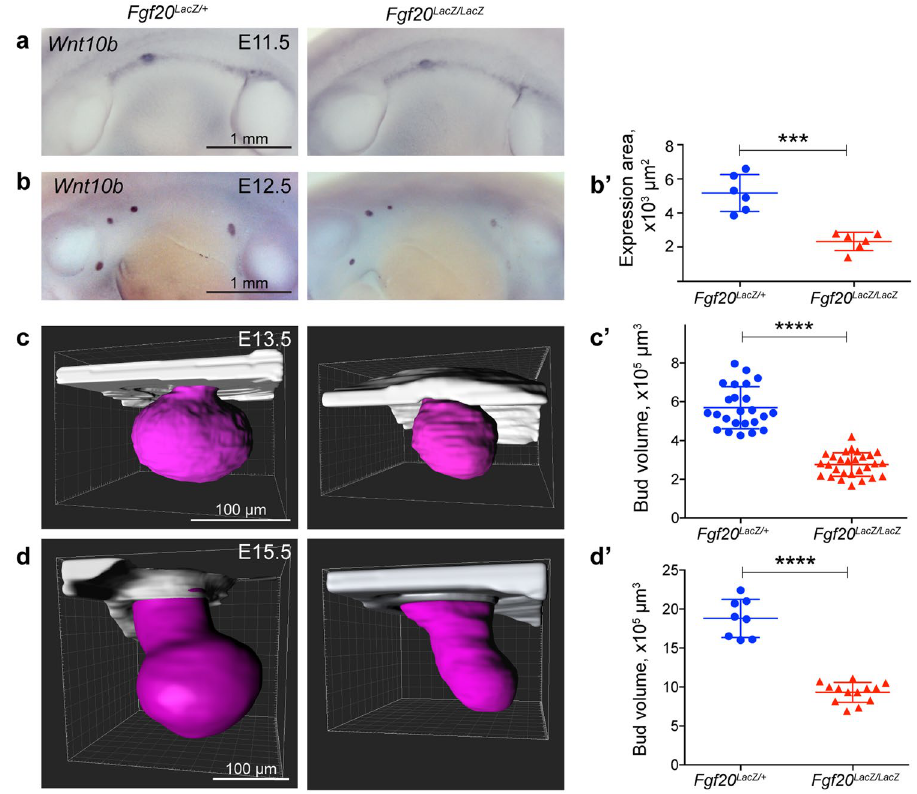
Figure 3. Fgf20 deficiency does not impede placode induction but compromises bud growth. ( a ) Expression of Wnt10b at somite stage 46–48 ( Fgf20 LacZ / + , n = 7; Fgf20 LacZ/LacZ , n = 7) and ( b ) E12.5 ( Fgf20 LacZ / + , n = 6; Fgf20 LacZ/LacZ , n = 6), and ( b’ ) quantification of Wnt10b expression area (mammary bud 3) at E12.5. ( d,e ) 3D images and volume quantifications of EpCAM-stained mammary bud 3 at E13.5 (Fgf20 LacZ / + , n = 24; Fgf20 LacZ/ LacZ , n = 28), and E15.5 (Fgf20 LacZ / + , n = 8; Fgf20 LacZ/LacZ , n = 13). The bud contours were outlined manually (purple) for volume quantification. *** p < 0.001; **** p < 0.0001.